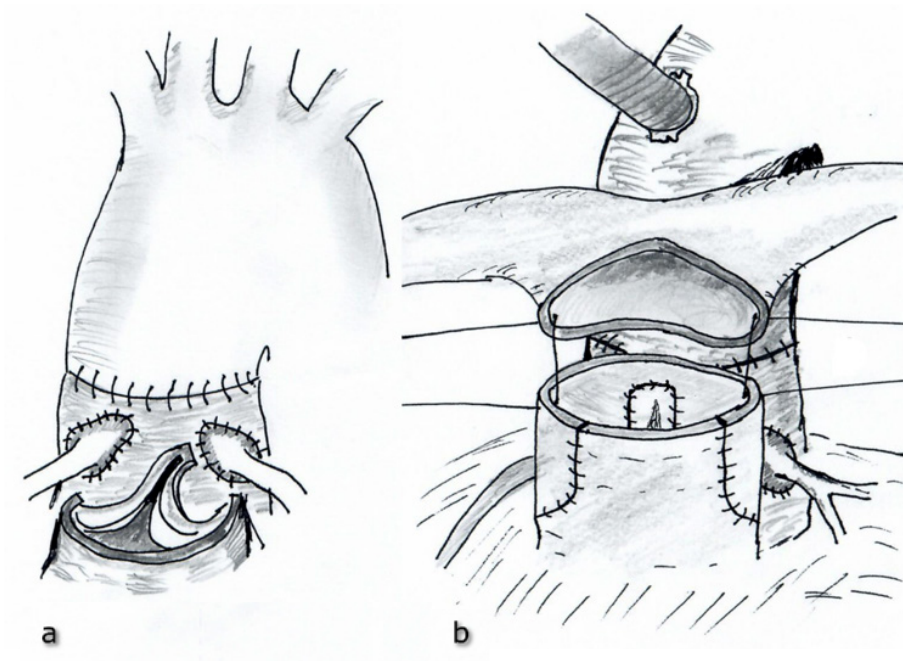
Fig. 2A – Completion of the neo-aortic reconstruction. Fig. 2B – Neo-pulmonary reconstruction and anastomosis between the neo-pulmonary artery and pulmonary